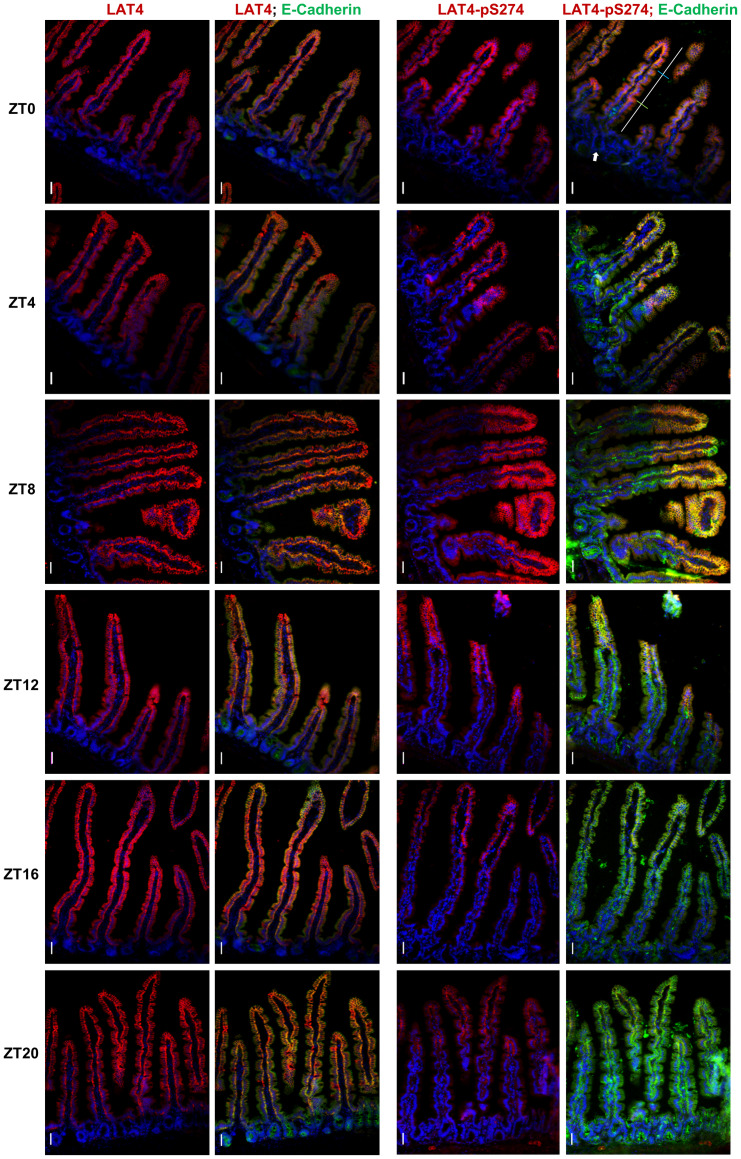
Phosphorylation on S274 in jejunum exhibits patchy localization and decreases during food anticipation and intake.Image at the upper right corner: white line marks the full length of villus, blue line demonstrates our applied border between the tip and middle part, and green line—border between middle and base part. Arrowhead marks crypt, where neither LAT4 nor pS274 staining is present. Red: LAT4 or pS274, green: E-Cadherin, blue: DAPI. Scale bar: 30 μm.